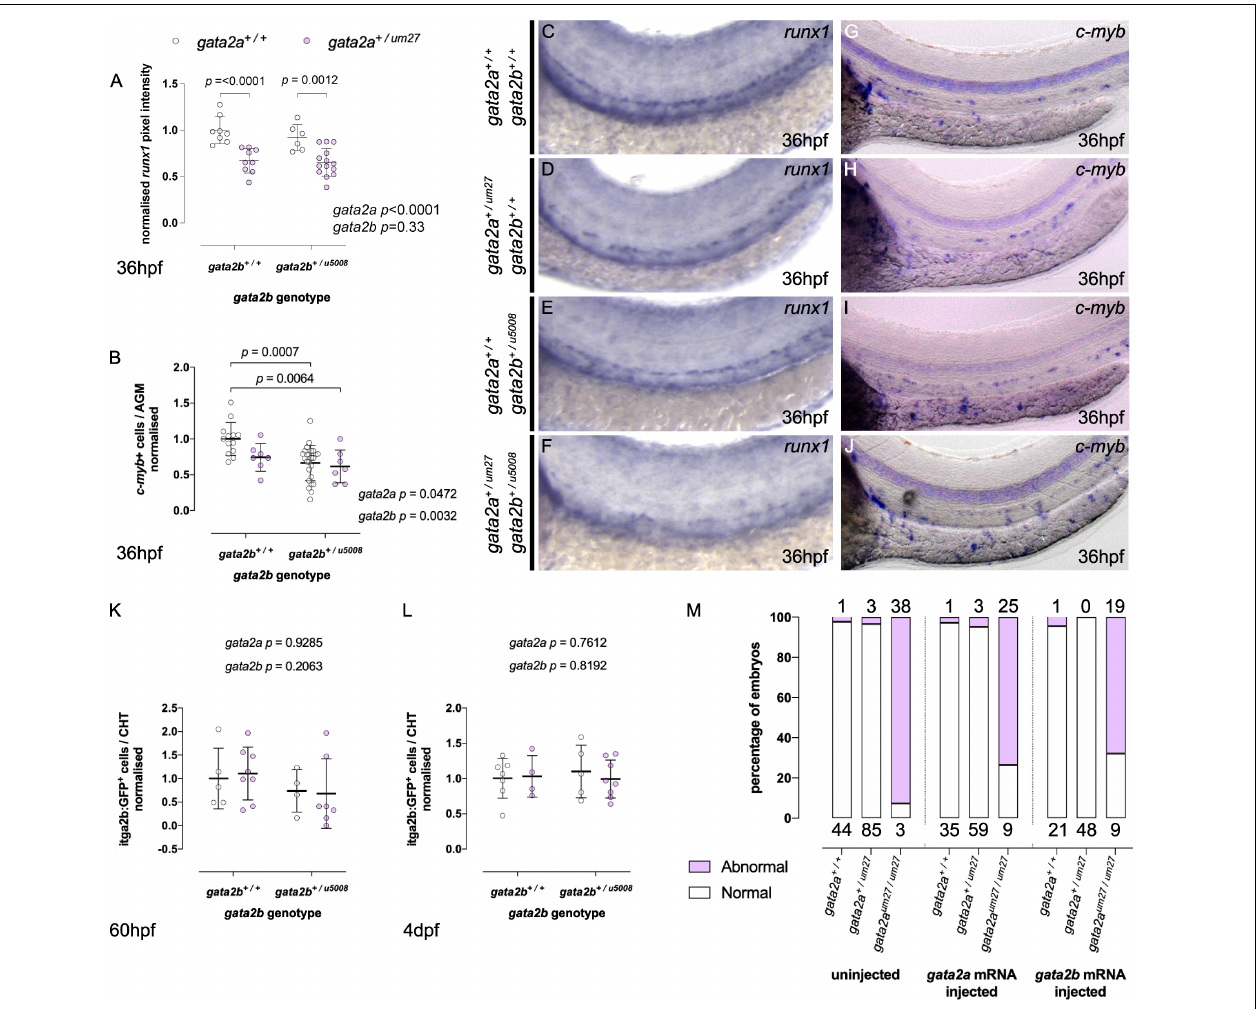
FIGURE 4 | Gata2a um 27 and Gata2b u 5008 mutations have independent and non-additive effects on HSPC specification. (A,B) Quantifications of runx1 expression (A) and c-myb + cells (B) in the AGM of 36 hpf of embryos from Gata2a + / um 27 to Gata2b + / u 5008 crosses. (C–J) Expression of runx1 (C–F) and c-myb (G–J) by in situ hybridization in 36 hpf embryos. In (K,L) , mutant fish carrying itga2b:GFP transgene, labeling HSPCs in the CHT, were used to quantify stationary GFP lo cells in the CHT of 60 hpf (K) and 4 dpf (L) fish. (M) The percentage of embryos displaying blood flow in the trunk in embryos injected with Gata2a (middle), Gata2b (right) mRNA is compared to that of uninjected embryos (left). Absolute numbers of abnormal (pink) and normal (white) embryos are indicated above and under the columns,